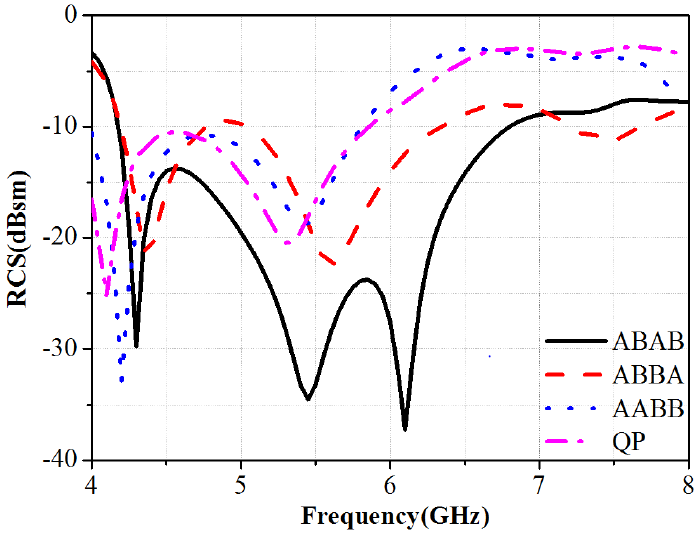
Figure 18. RCS simulation results of different array forms.